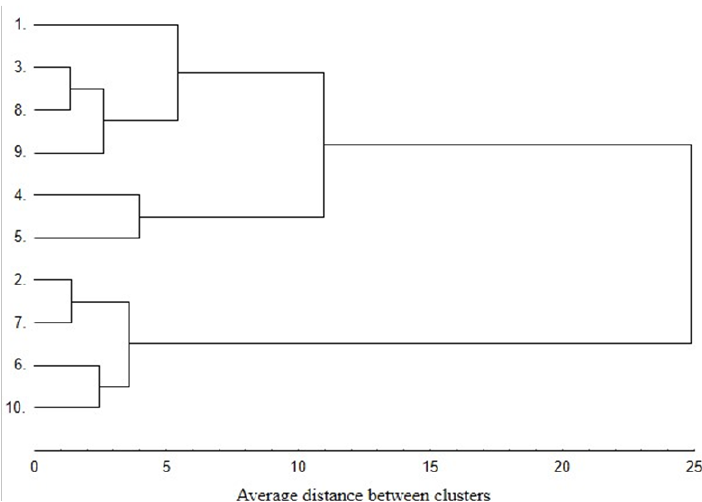
Figure 3. Dendrogram estimating distance between 10 stevia genotypes based on steviol glycosides (% DW) and polyphenols (mg · g − 1 DW)